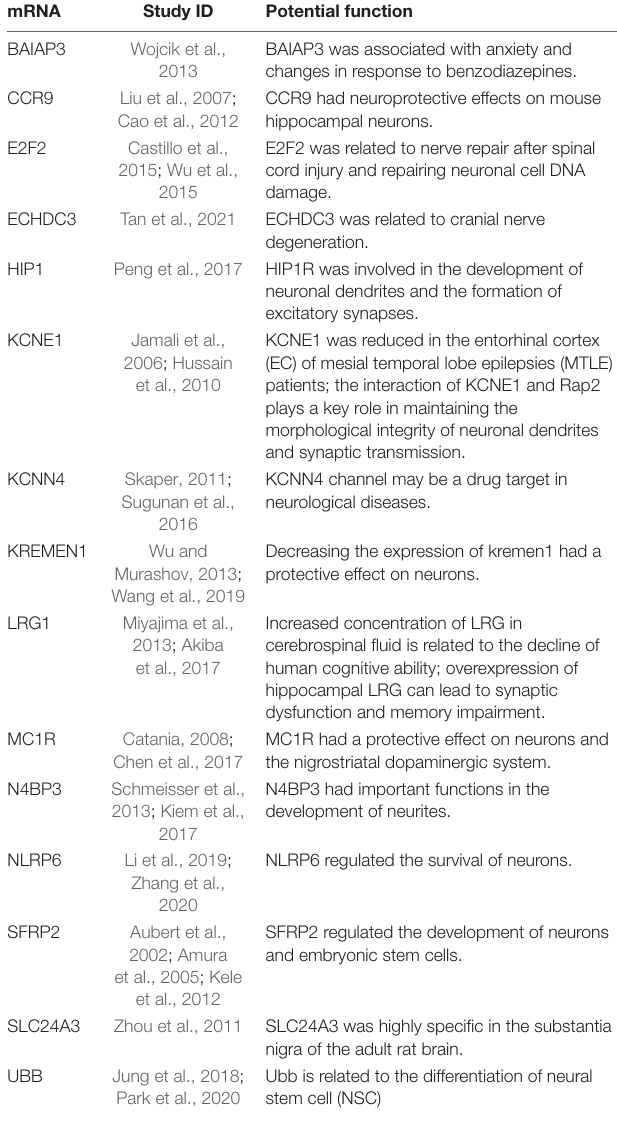
mRNA Study ID Potential